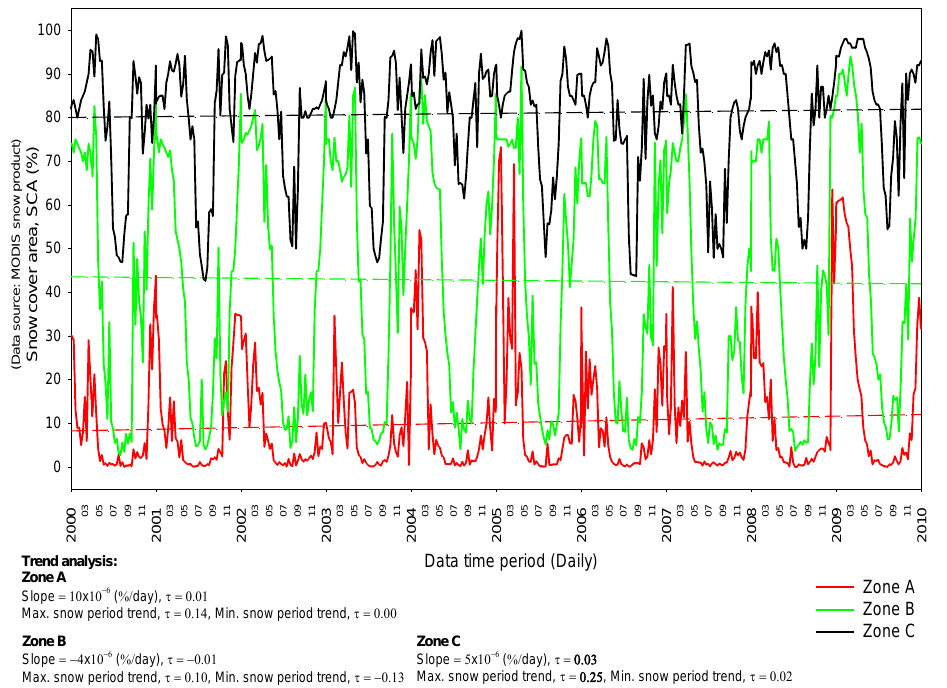
Fig. 5 Snow cover distribution in three different altitudinal zones of the Hunza River basin. Increasing trend (though not significant) can be noted in zone C. Seasonal Mann Kendall’s trend analysis is also presented for maximum (November-February) and minimum (June-September) snow cover periods. (Kendall’s tau ( τ ) coefficient values presented in bold figures indicate an increasing trend with p <0.05). period 1961 to 2000. Hussain et al. (2005) indicated